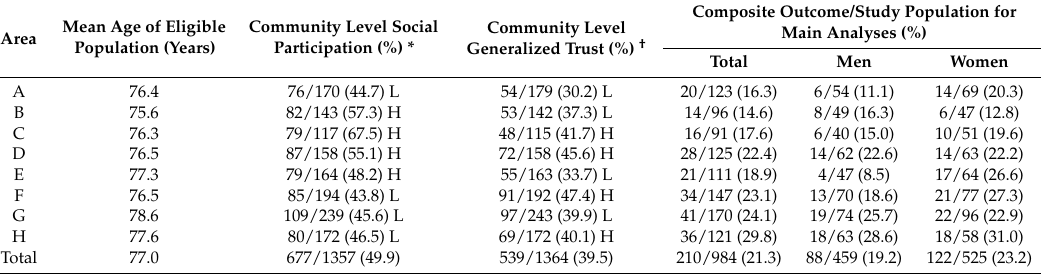
Table 2. Area characteristics.